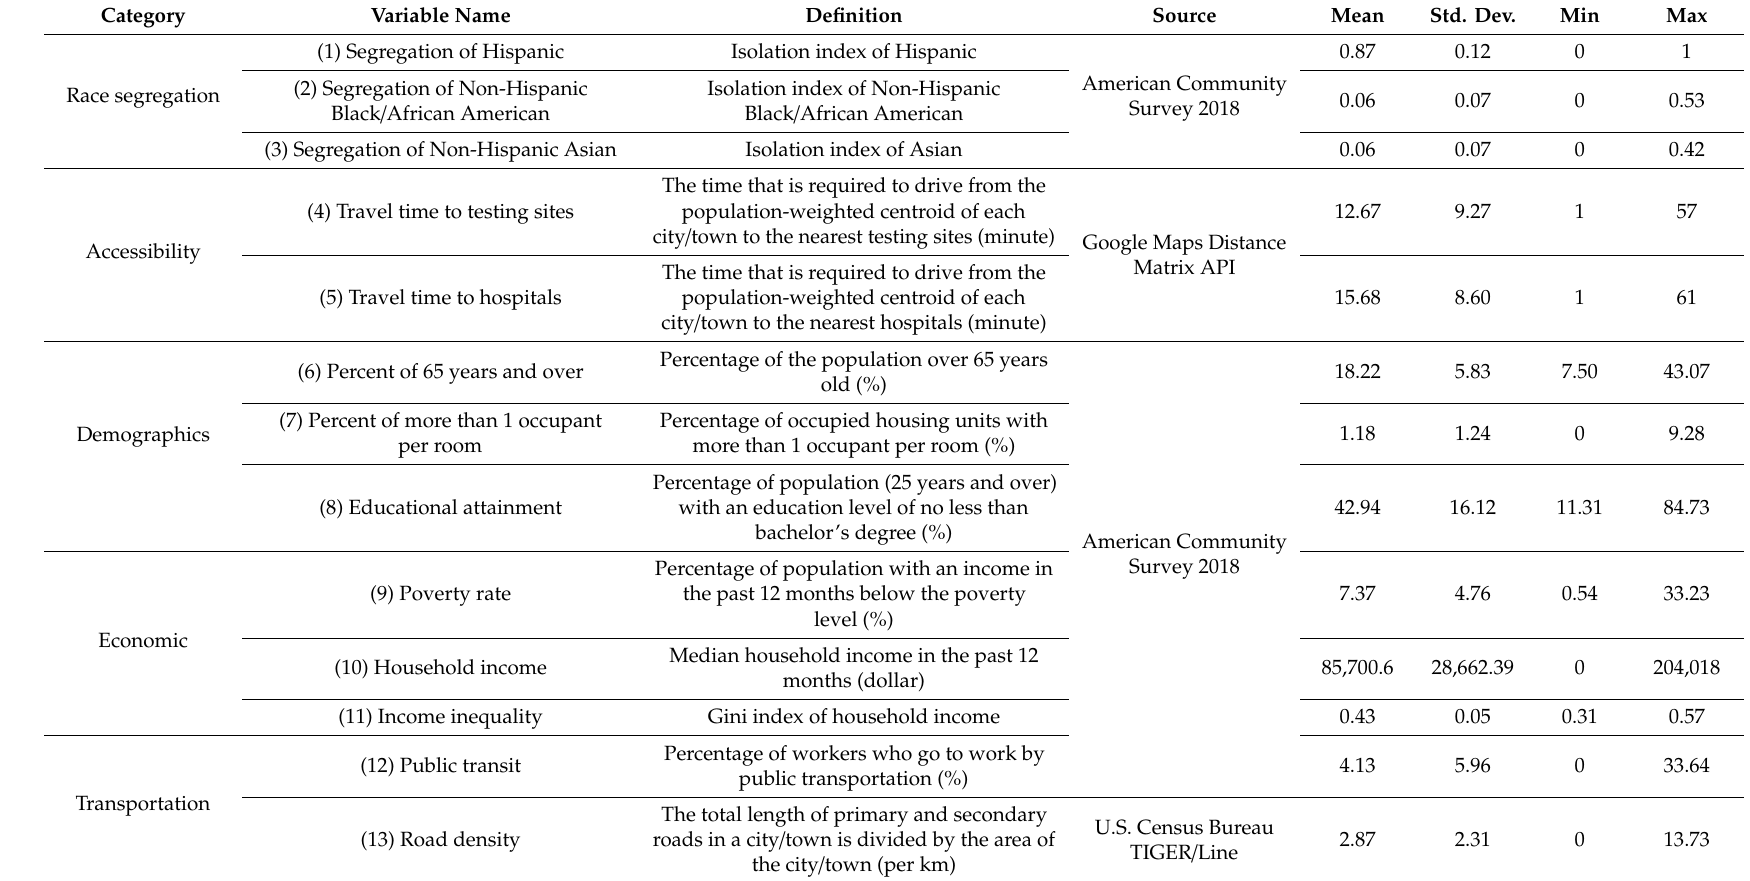
Table 1. Definition, sources, and summary statistics of explanatory variables used in this